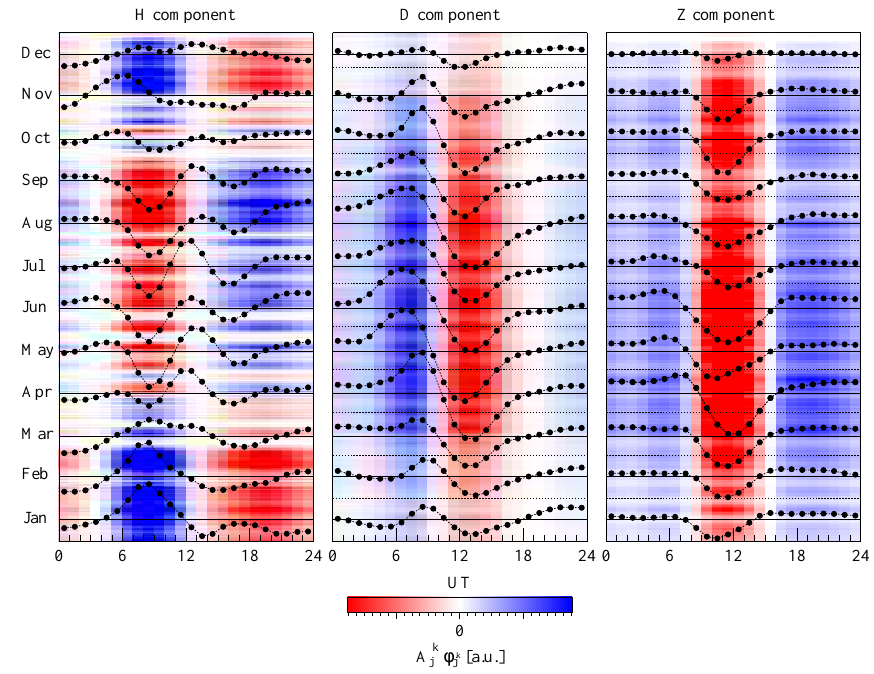
Fig. 5. Comparison between the seasonal dependence of the 1996 quiet daily variation of the three magnetic field elements (H, D and Z) as reconstructed by multiplying each EOF for the corresponding amplitude PC (negative and positive values are in red and blue, respectively) for the year 1996 and the true S q (black circles) evaluated by averaging the daily variation of the 5 quietest days of every month. Solid horizontal lines refers to the average S q values for the true daily variation. A moving average over 5 days has been applied on the A k reduce the noise for visualization purposes. Time is reported in universal time (UT = LT − 1) for convenience.